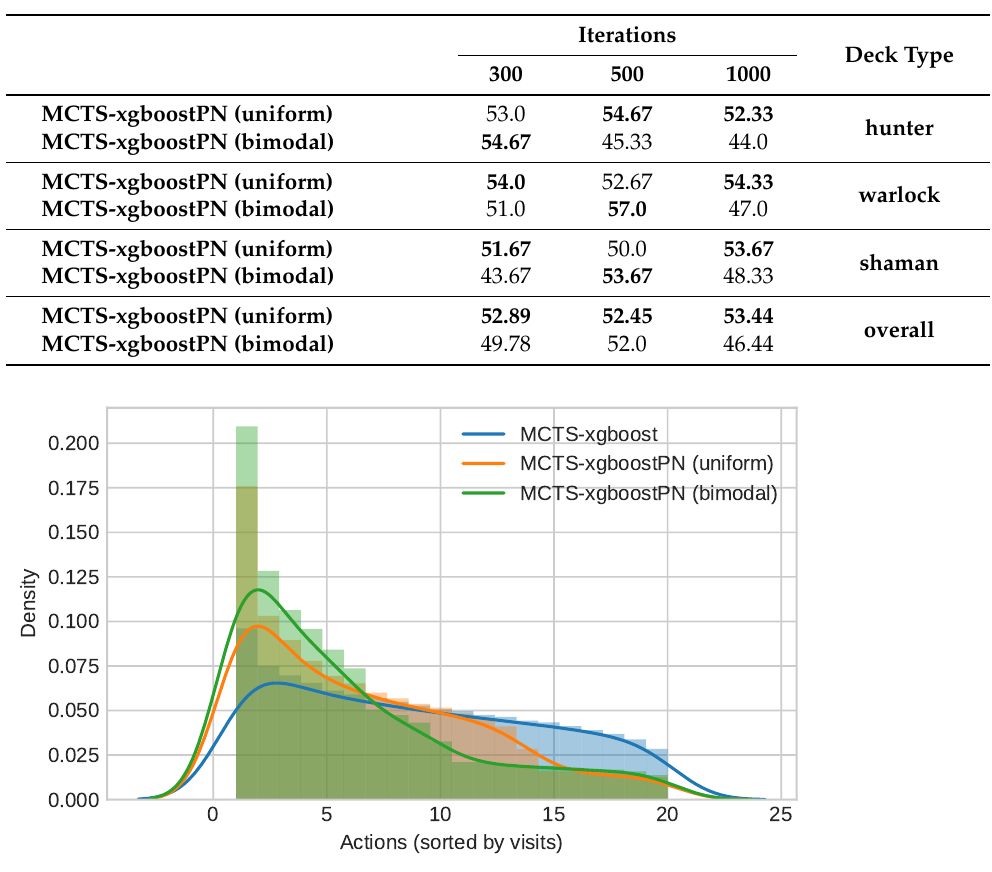
Figure 3. Actions’ visits distributions with and without pruning networks (300 iterations).